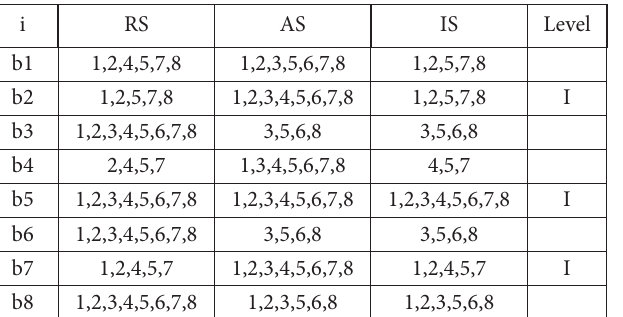
Table 4. Level partition –